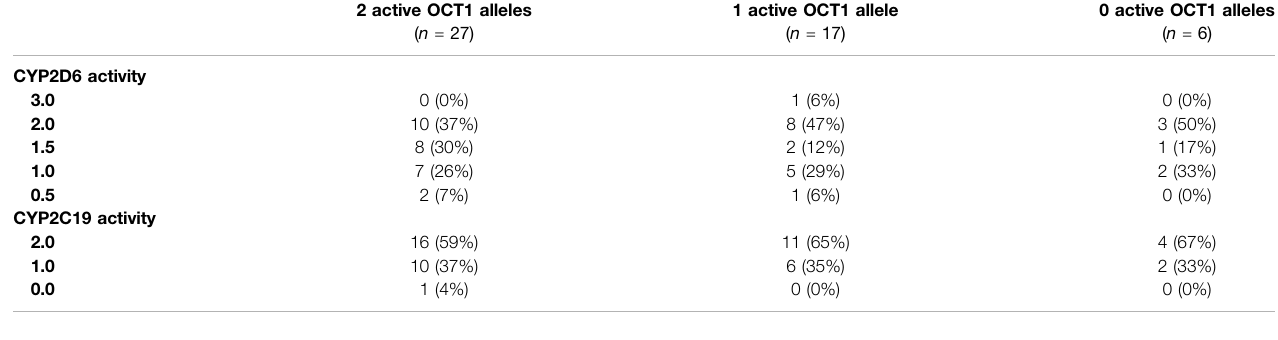
2 active OCT1 alleles ( n (cid:1) 27)